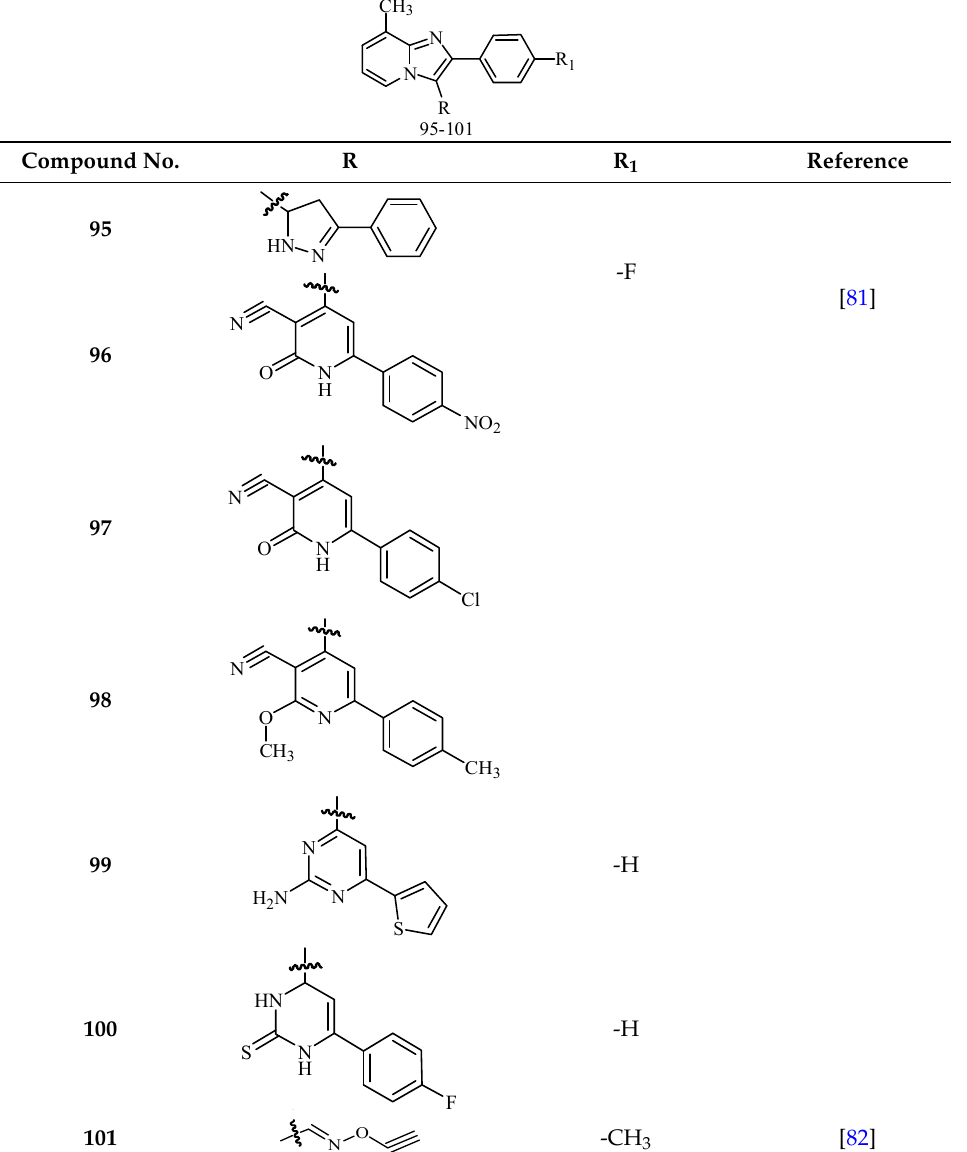
Table 5. Anticonvulsant imidazole compounds.